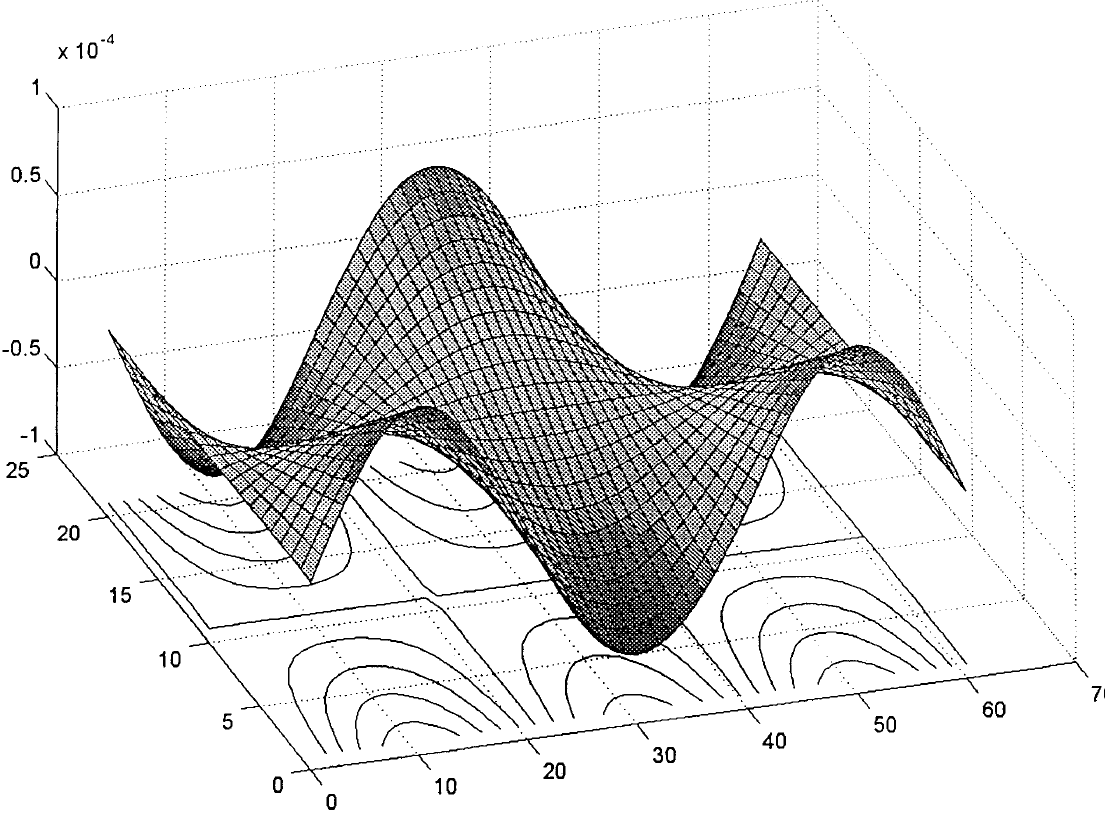
Fig. 8. Third mode shape of 3-span deck, φ 1 = φ 2 = 1 . 0 , φ 2 = 1 . 1